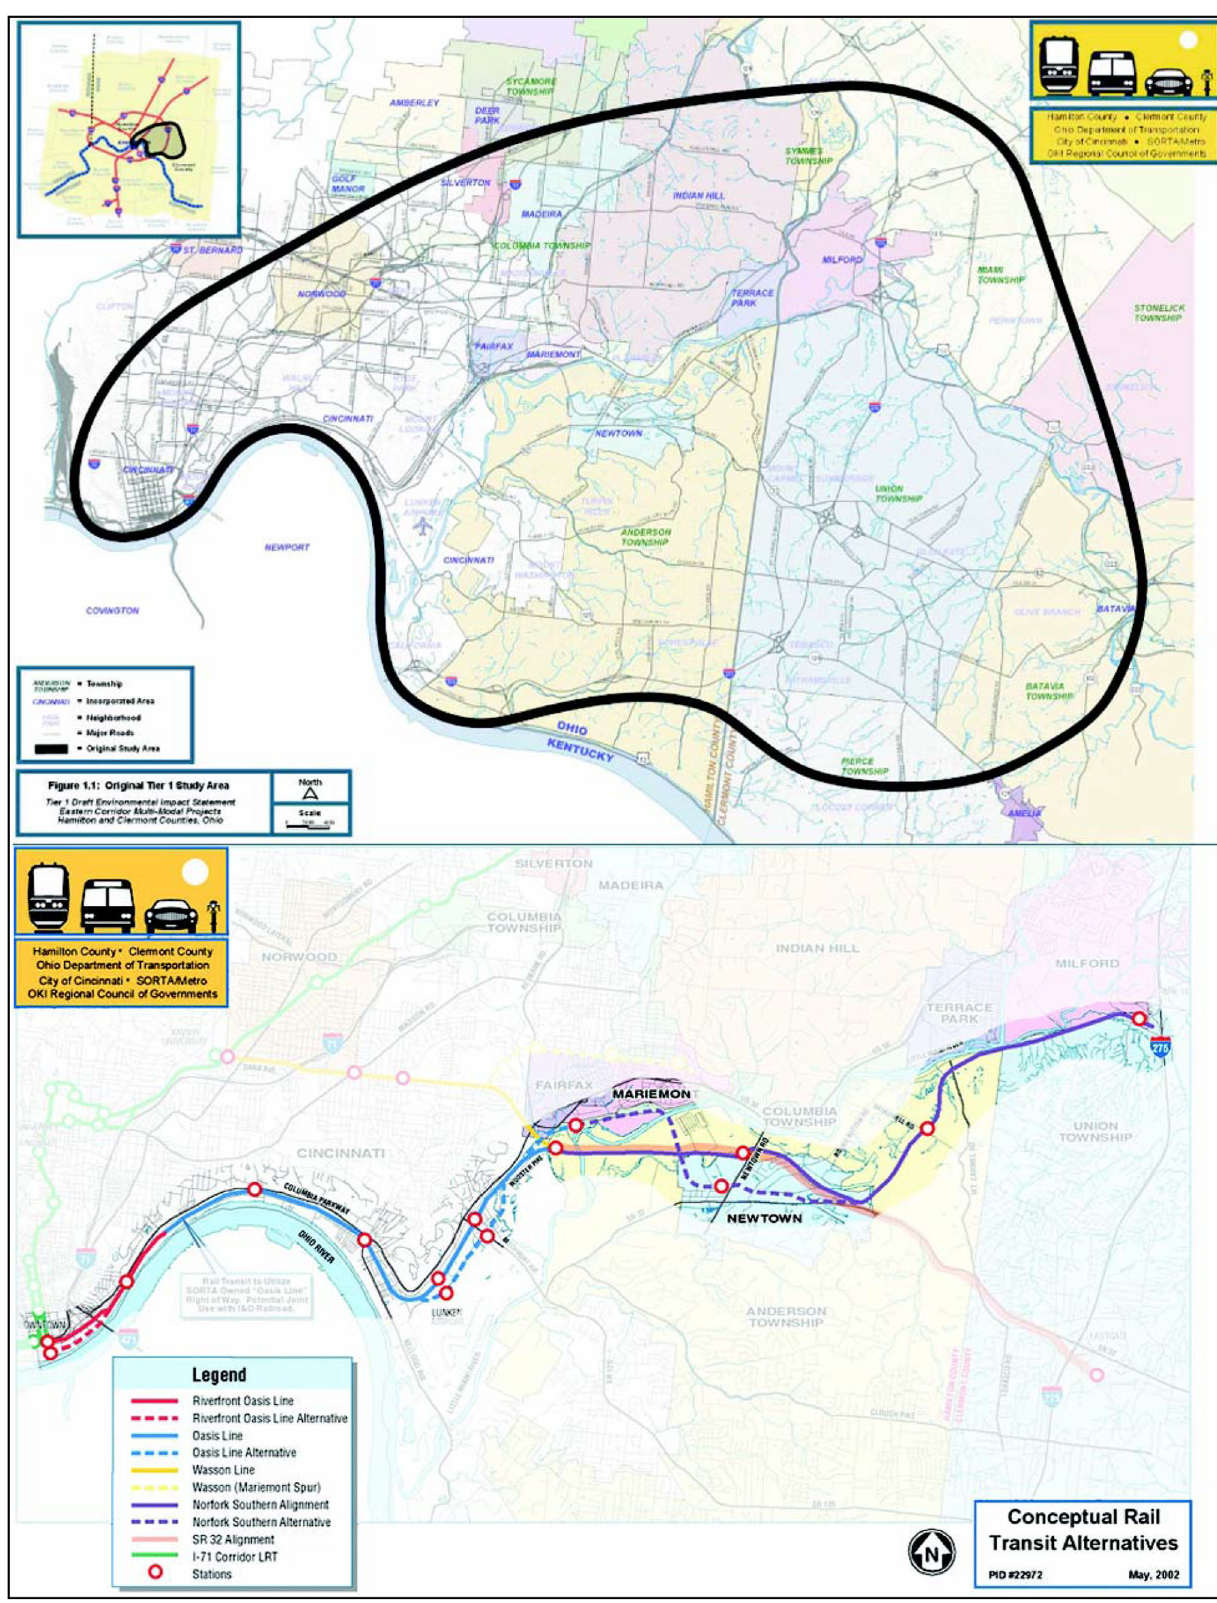
Fig. 1 The Cincinnati Eastern corridor study area and the Oasis Line study area